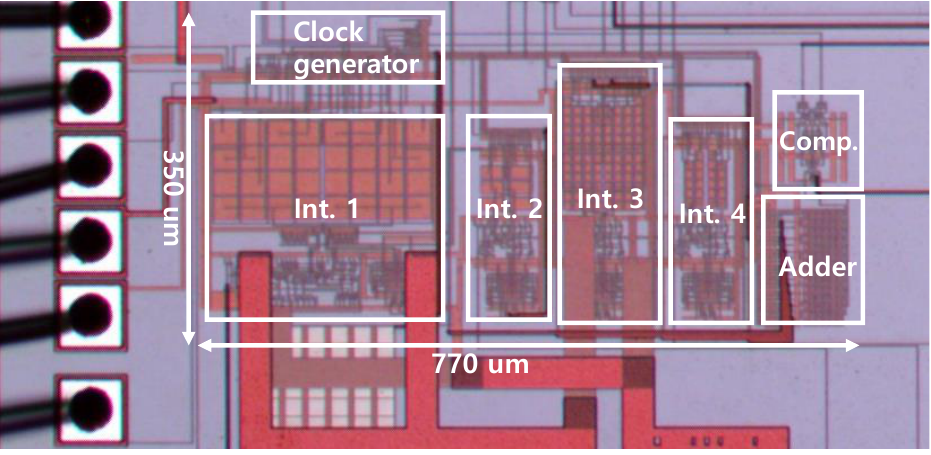
Figure 10. Chip Figure 10. Chip microphotograph.